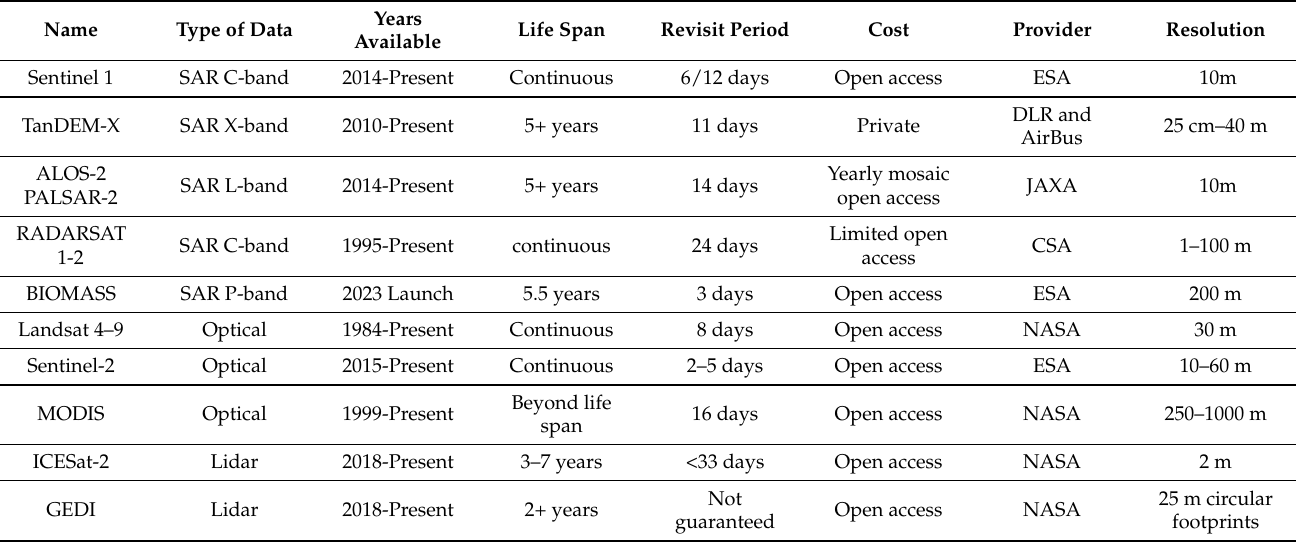
Table 1. Satellite data sources available for future AGB